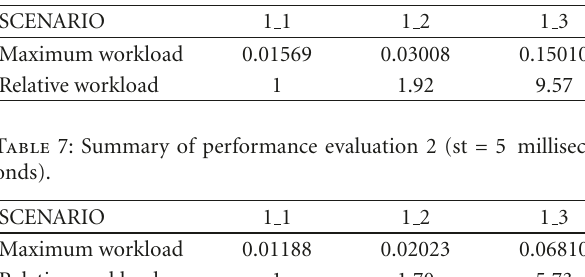
Table 6: Summary of performance evaluation 1 (st = 1 ms).